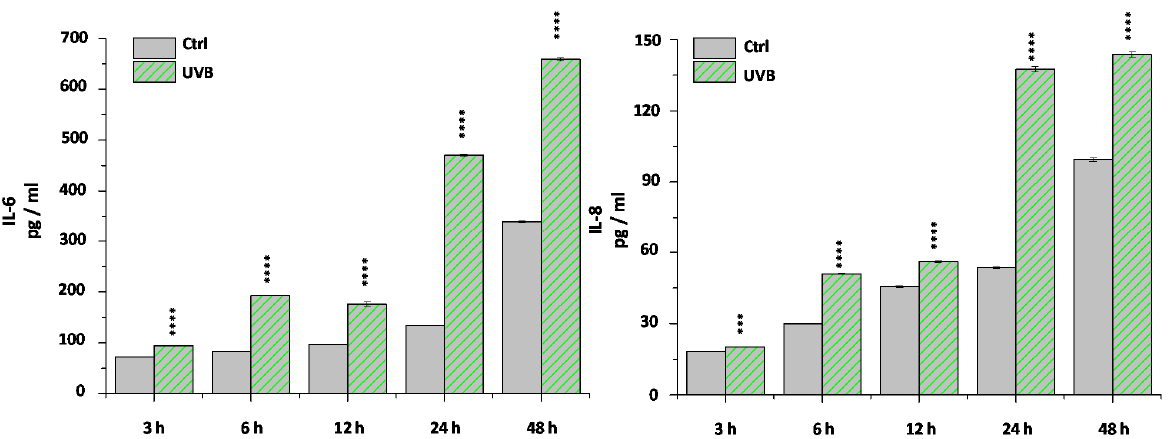
Figure A1. Time course of cytokine secretion after UVB irradiation from HCEC cells. ELISA determination of IL-6 and IL-8 in the supernatant of human corneal epithelial cells following UVB irradiation at the marked time points. Data are expressed as mean ± SD of three independent determinations. ***, **** mark significant ( p < 0.001, 0.0001, respectively) changes compared to the relevant time-matched control